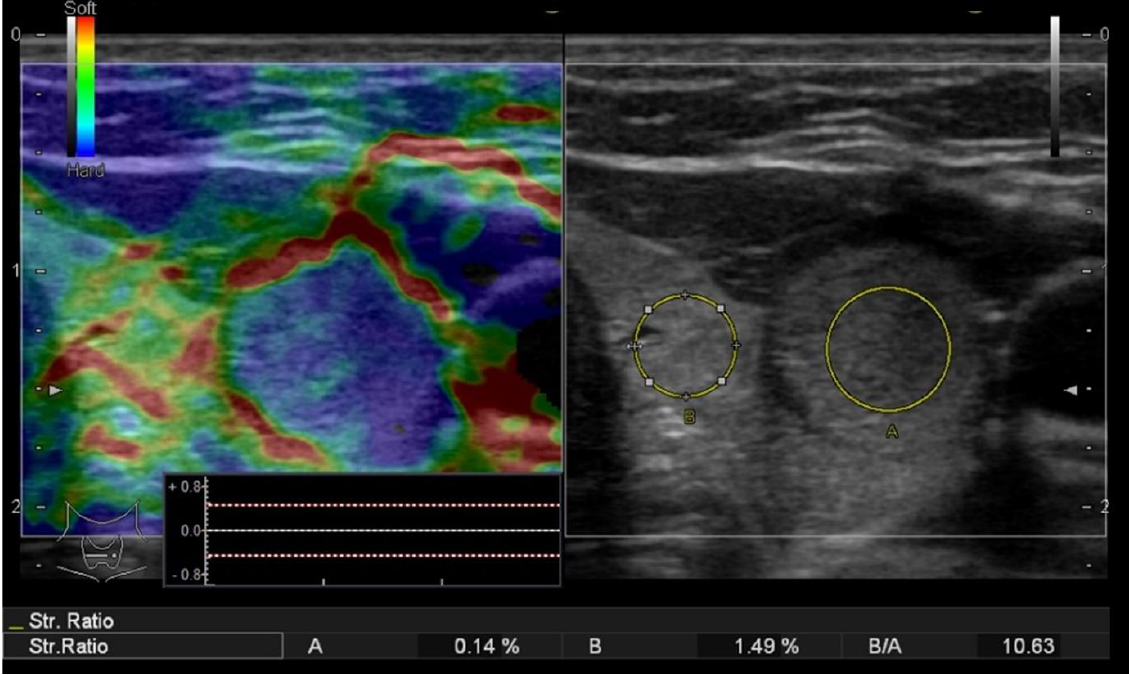
Figure 2. Strain elastography ( left ) evaluation displaying a colormap overlaid on the greyscale image, Asteria score 4 (completely stiff/color blue); the nodule-to-parenchyma strain ratio (region of interest A covering the nodule and region of interest B in the healthy, adjacent thyroid parenchyma) displaying an increased value = 10.63 and the conventional ultrasound image ( right ) of a solid thyroid nodule.